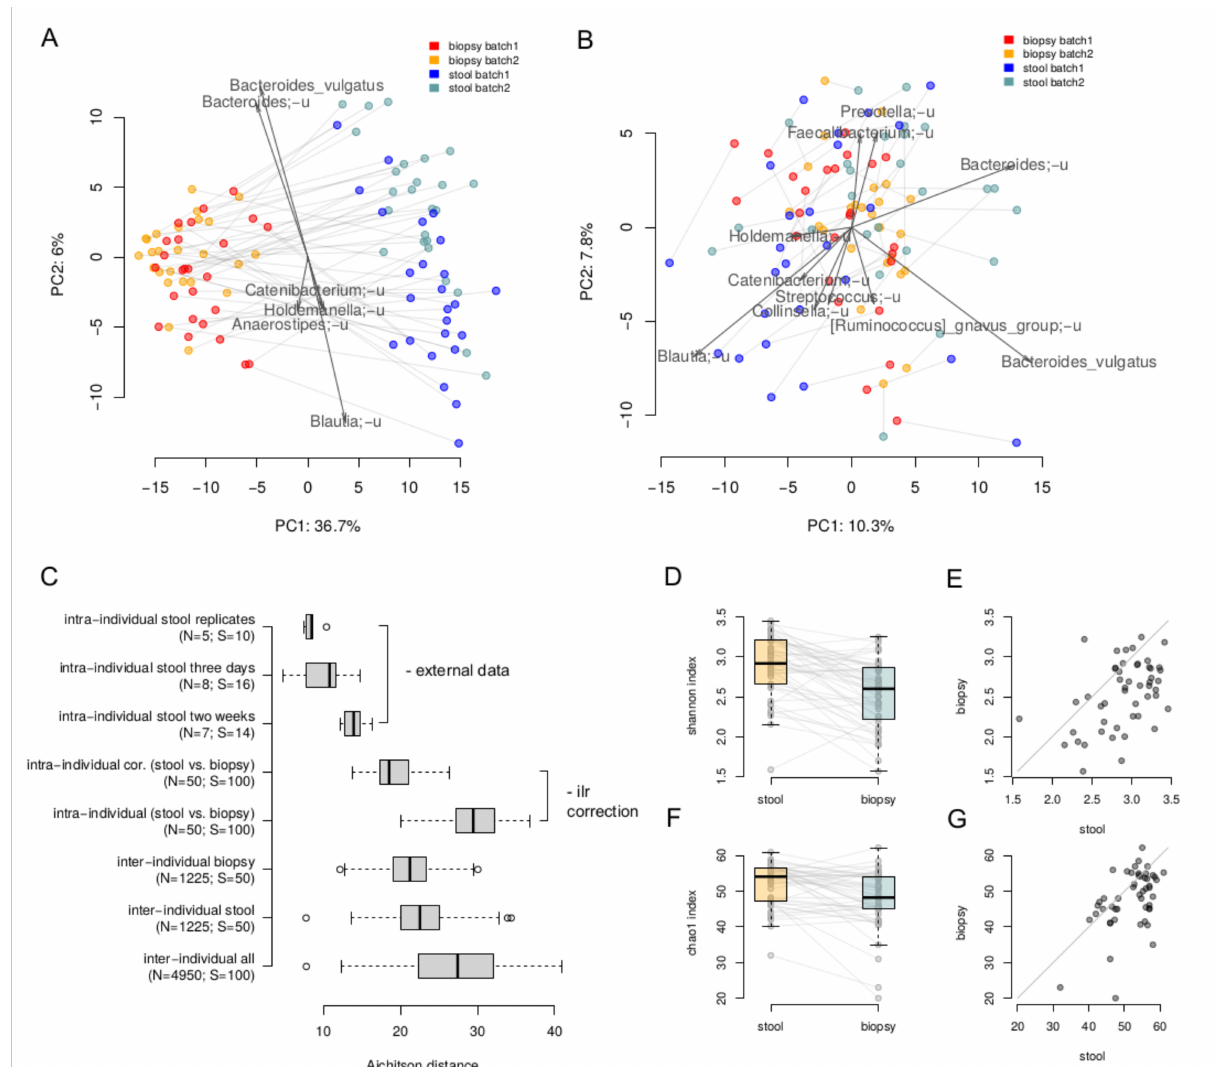
Figure 1. Comparison of paired luminal and tumor-associated microbiomes. ( A , B )—The stool and biopsy compositions are visualized using PCoA (Principal Coordinates Analysis) based on the Aitchison distance. Arrows show the top taxa in terms of the explained variance in given axes. An arrow length is proportional to the percent of variance explained by the taxon. An arrow angle reflects the distribution of this variance between the axes (( A )—before the correction; ( B )—after correction in the ilr coordinates). ( C )—Intra and inter-individual variation between samples. Variation between stool samples from the same person obtained from the same sample (“intra-individual stool replicates”), with 3 days (“intra-individual stool three days”) and 2 weeks (“intra-individual stool two weeks”) gap was estimated using the previously published data [34]. Variation between stool and biopsy samples of one patient was calculated before (“intra-individual”) and after (“intra-individual cor.”) the correction. The number of distances computed in each group as well as number of samples are given in brackets. ( D , E )—Comparison of alpha diversity of the stool and biopsy samples (Shannon metric). ( F , G )—Comparison of alpha diversity of the stool and biopsy samples (Chao1